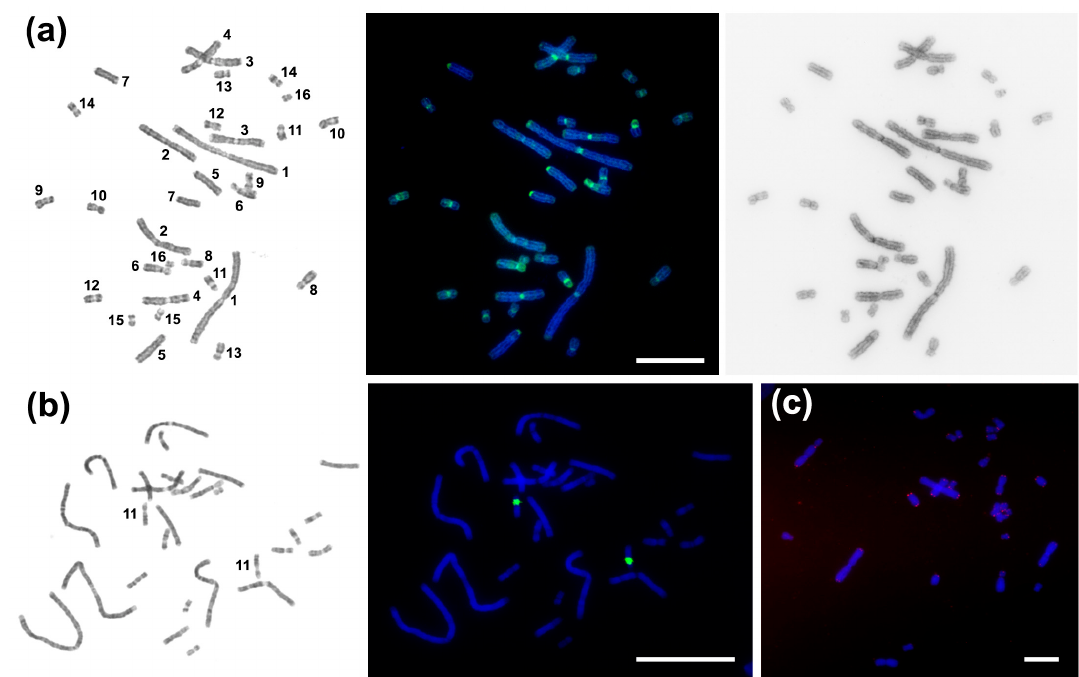
Figure 2. CDAG-staining and localization of 18S/28S-rDNA and telomeric probes on Crocodylus niloticus metaphases chromosomes. ( a ) CDAG-staining. From left to right: GTG-banded chromosomes, CDAG-staining, inverted DAPI-banding. Bright blue blocks contain AT-rich DAPI-positive heterochromatin. Bright green blocks consist of GC-rich CMA 3 -positive heterochromatin; ( b ) Localization of 18S/28S-rDNA probe: GTG-banding on the left; ( c ) Localization of telomeric repeat (TTTAGG) n . Scale bar 10 µm.